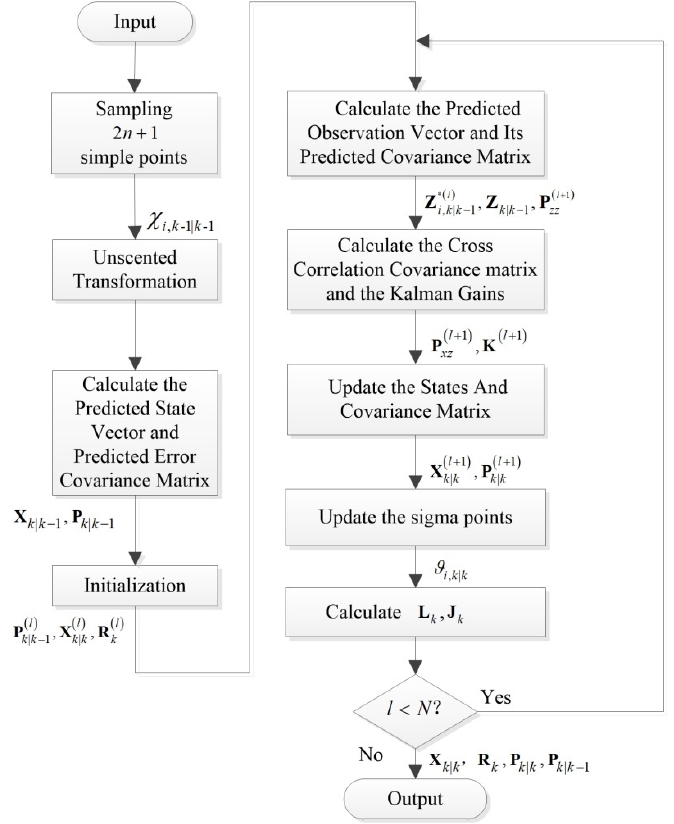
Figure 4. The flowchart of the proposed SRAKF.